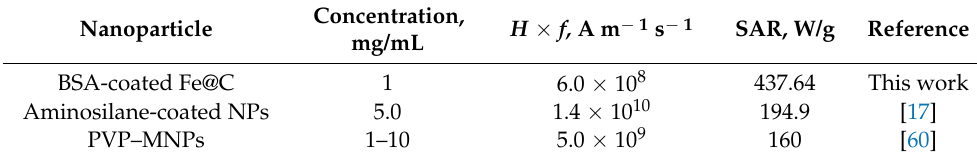
Table 3. SAR values comparison of our results with commonly used magnetic